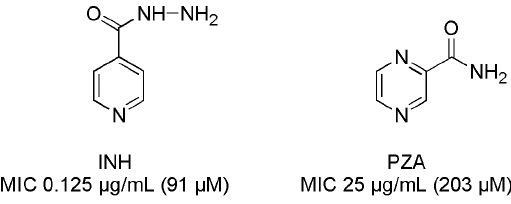
Figure 1. Structure and tuberculostatic activity of isoniazid ( INH) and pyrazinamide ( PZA) .